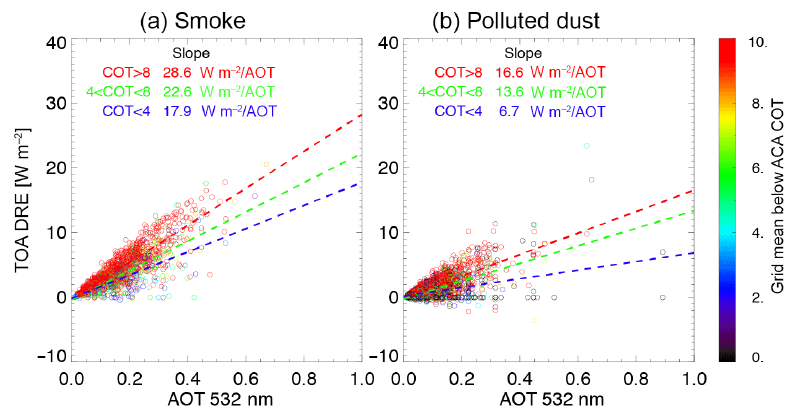
Figure 10. Dependence of grid-mean diurnally averaged DRE at TOA on grid-mean ACA AOT for (a) smoke and (b) polluted dust in the SE Atlantic Ocean from 8 years of CALIOP observations. The colors correspond to grid-mean underlying COT.